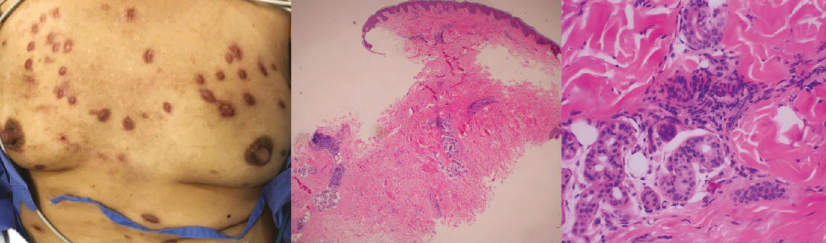
Figure 1: Multiple, discrete, firm, smooth, skin-colored, and hyperpigmented papules as well as plaque on the upper chest, abdomen, and both knees (left). Haematoxylin and eosin stain histopathology of a skin biopsy (middle) using low power field revealed perivascular and peri-adnexal lymphohistiocytic infiltration in the deep dermis, while (right) high power field revealed periductal mixed inflammatory cell infiltration, representing a dermal inflammatory reaction.